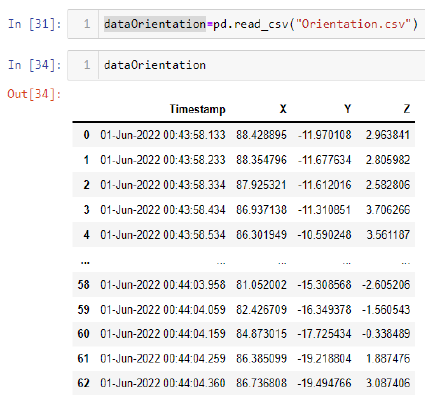
Figure 51. Orientation sensor data.